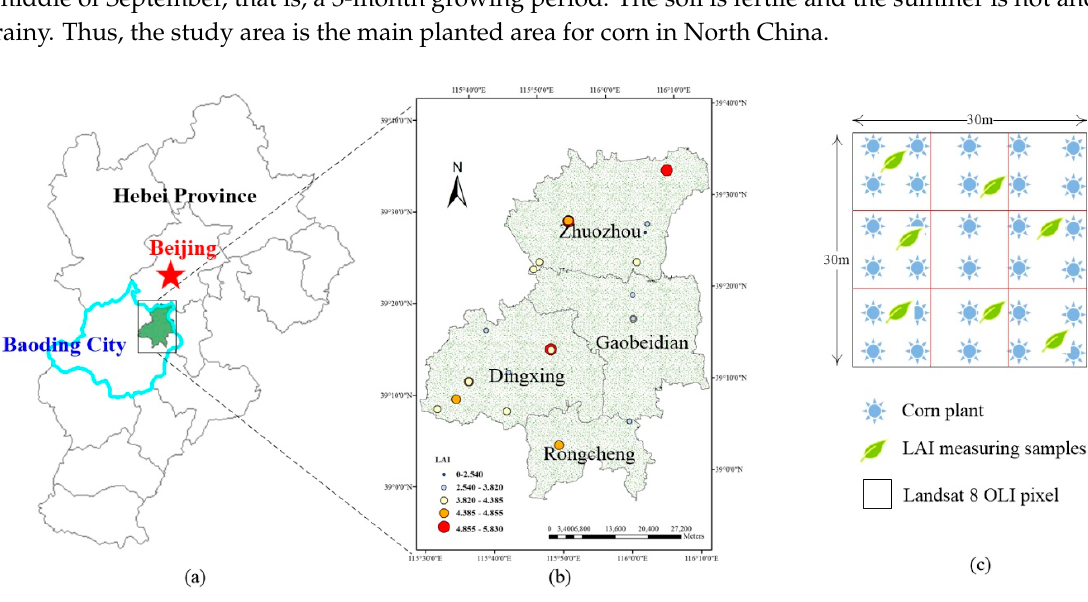
Figure 1. Location of the study area ( a ), the distribution of sampling quadrats in field work ( b ), and sampling pattern used in the fieldwork ( c ).